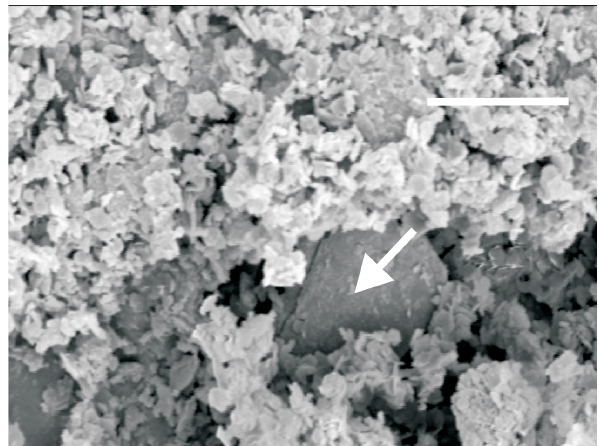
Figure 3. SEM image of a taranakite aggregate overgrown by fran- coanellite. The arrow indicates a roughly hexagonal crystal. The scale bar (top) represents